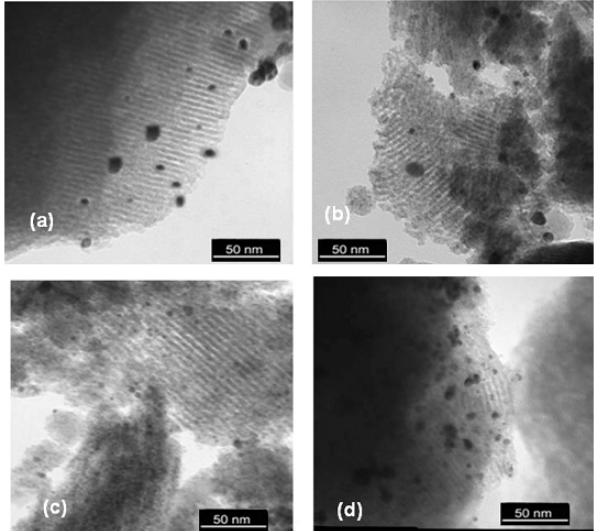
Figure 2. STEM images of as-synthesized catalysts: ( a ) Au/SBA-15; ( b ) Au/Ce5-SBA-15; ( c ) Au/Ce20-SBA-15 and ( d ) Au/Ce30-SBA-15. Reproduced with permission from [27]. Copyright 2012 Elsevier B.V.